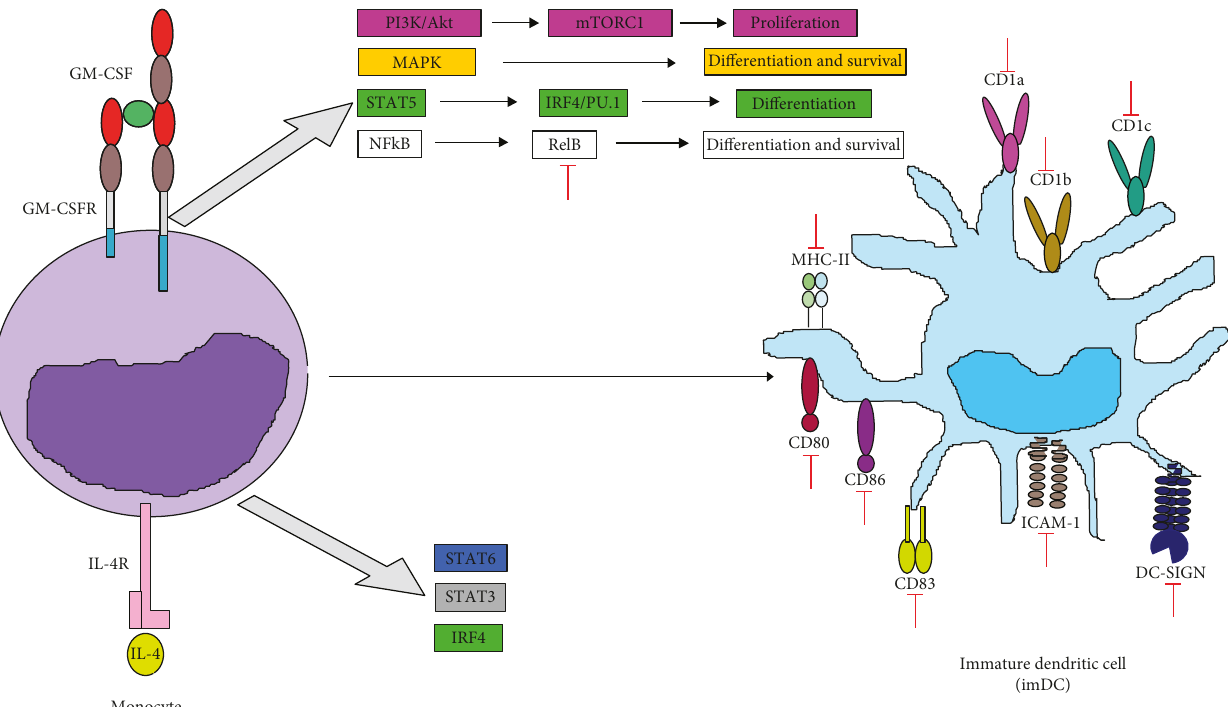
Figure 4: VPA inhibits monocyte to DC cell di ff erentiation. VPA suppresses monocyte to DC di ff erentiation after being stimulated with IL-4 and GM-CSF, by a ff ecting RelB translocation (a noncanonic NF- κ B subunit) into the nucleus, which contributes to the reduction in the expression of diverse characteristic surface molecules from immature DCs, including costimulation (CD80, CD83, and CD86), adhesion (ICAM-1/CD54 and DC-SIGN), MHC-II (HLA-DR), and CD1 isoform (a, b, and c) molecules. Green arrows indicate the processes, molecules, or mediators in the signaling pathway that are augmented and/or promoted by VPA. Red arrows indicate processes, molecules, or mediators in the signaling pathway that are inhibited by